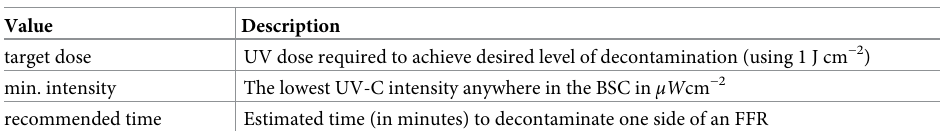
Table 2. Description of equation